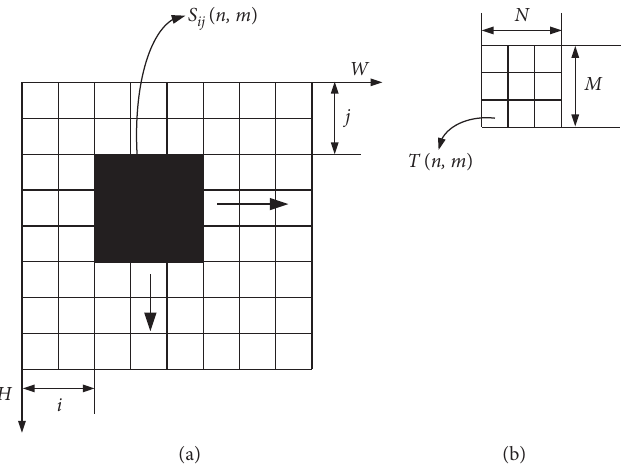
Figure 1: The principle of GTM. (a) Searched image S S ( W , H ). (b) Template image T T ( N , M ).